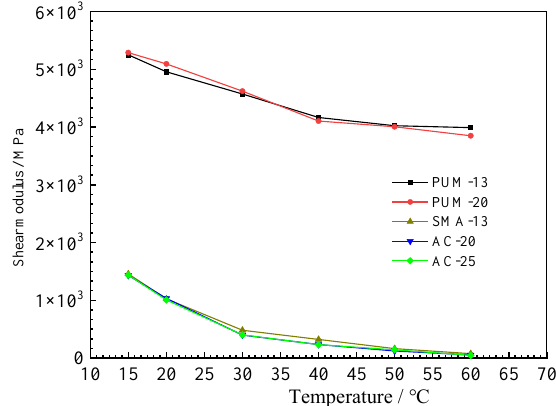
Figure 11. Shear modulus test results.